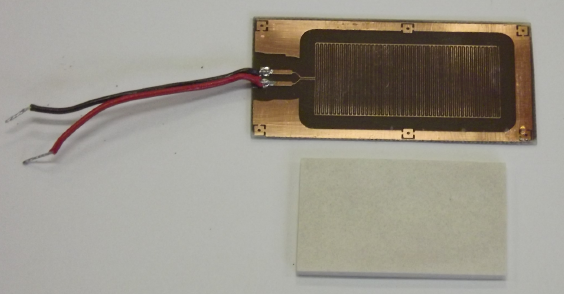
Figure 2. Photograph of the PCB with interdigitated electrodes ( top ) and a porous ceramic plate ( bottom